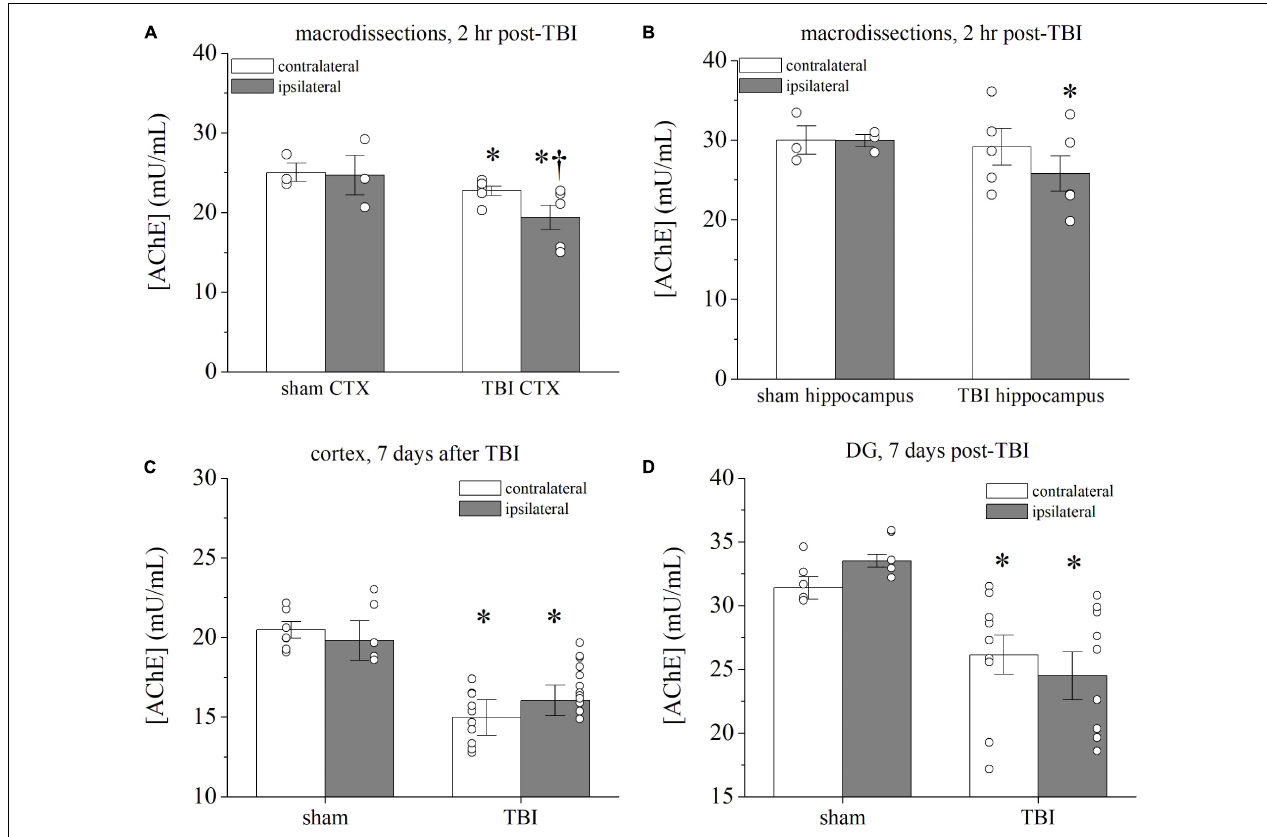
FIGURE 6 | Prolonged decrease in AChE within hippocampus and cortex after CCI-TBI. (A,B) Summarized data for acetylcholinesterase (AChE) assay of macrodissected brains [CTX = cortex in panel (A) , HC = hippocampus in panel (B) ] 2 h after TBI or sham procedure. The assay measures Amplex Red fluorescence of acetylcholinesterase enzymatic activity. Bars represent concentration of acetylcholinesterase present in protein homogenates in mU/ml. Ipsilateral cortex and hippocampus of TBI mice exhibit significant decrease in AChE compared with contralateral tissue. (C,D) Summarized data for AChE assay in panel (C) DG and (D) cortex 7 days after TBI. Whereas ipsilateral and contralateral AChE was not significantly different, TBI tissue exhibited significantly less AChE activity than sham controls. All data bars represent the mean ± SEM. * p < 0.05 vs. sham tissue, † p < 0.05 vs. contralateral tissue. n = 5–12 mice per